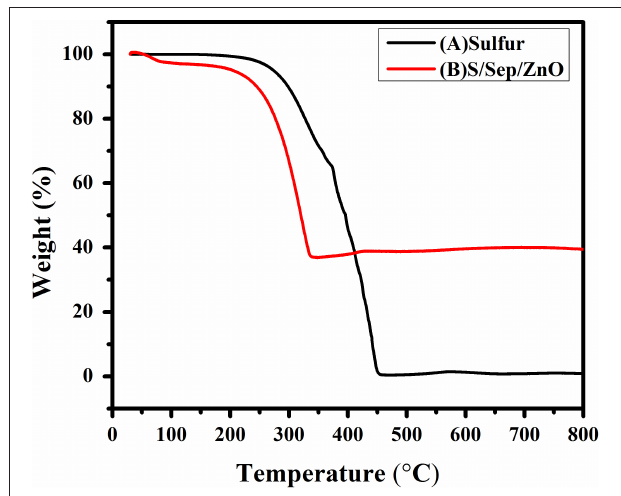
FIGURE 1 | TGA curves of (A) pure sulfur (B)